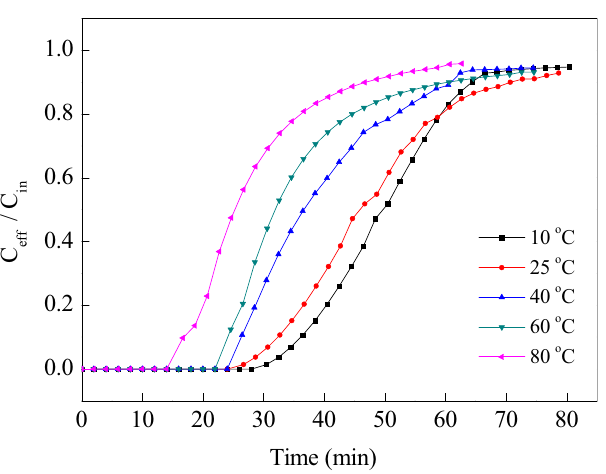
Figure 10. Breakthrough curves of CO 2 adsorption on PP-AM-HBP-NH 2 at different adsorption temperatures (alkyl amino content of PP-AM-HBP-NH 2 was 6.39 mmol/g).